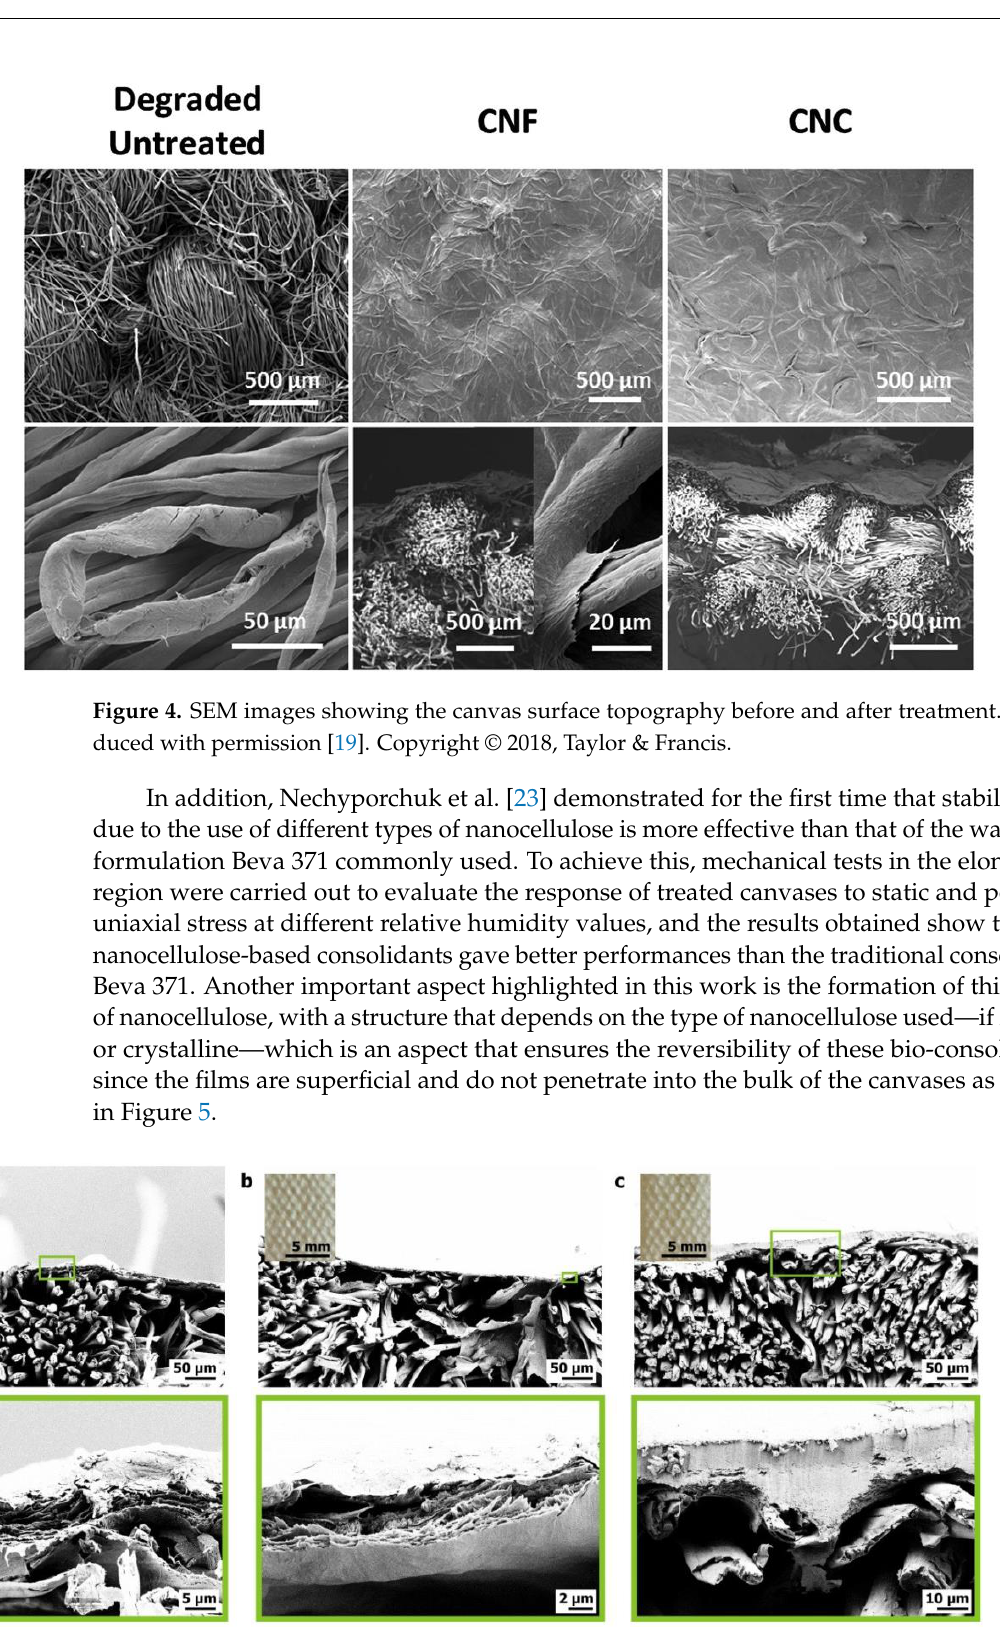
Figure 5. SEM images of aged cotton canvases coated 3 times with: ( a ) CNF; ( b ) carboxymethylated CNF; and ( c ) CNC, with optical microscopy images as insets (left top). Reproduced with permission. [23]. Copyright © 2018, Elsevier.